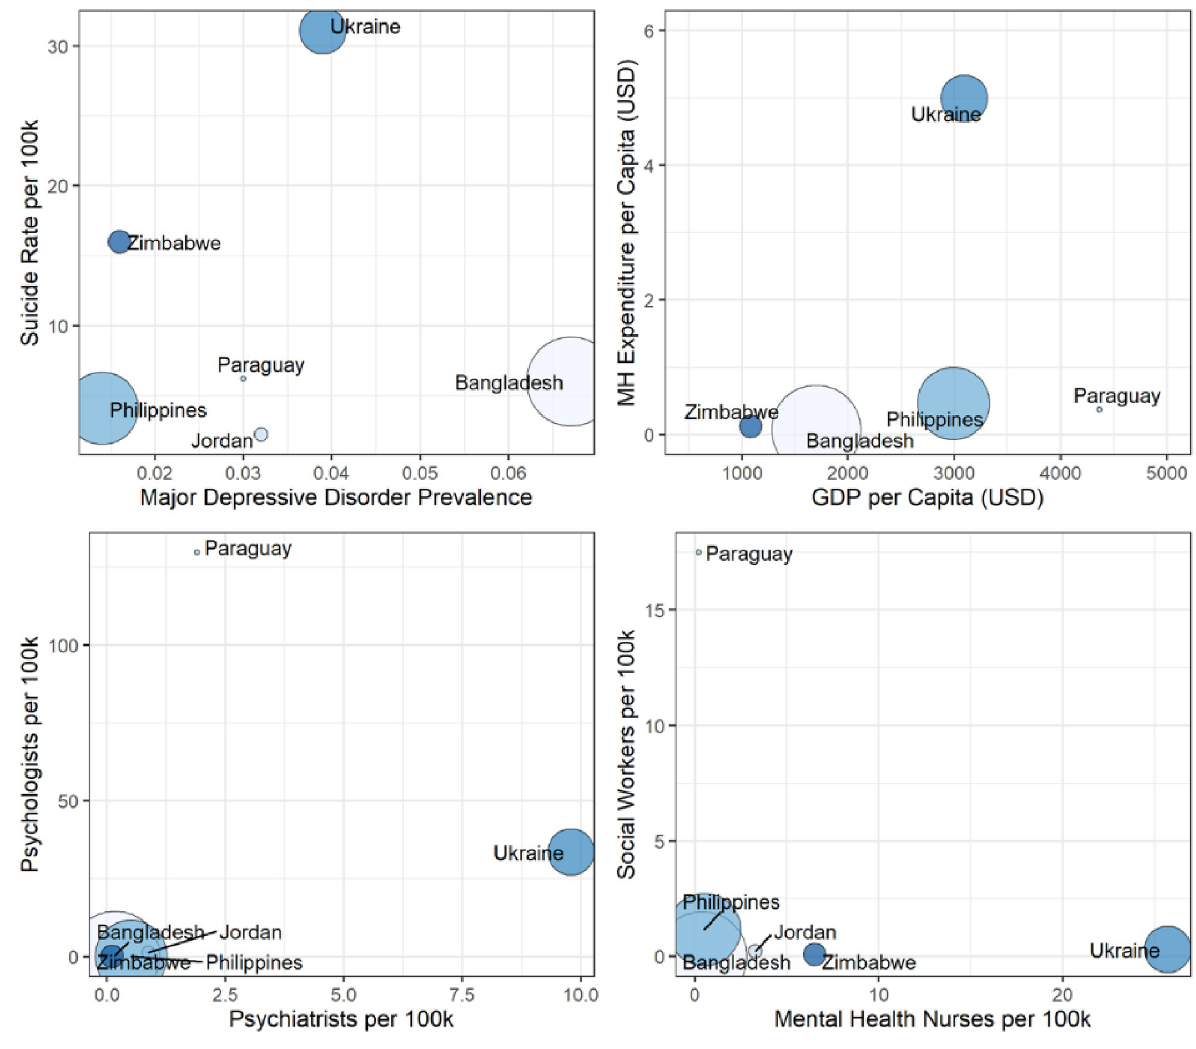
Fig 1. Comparisons of country mental health